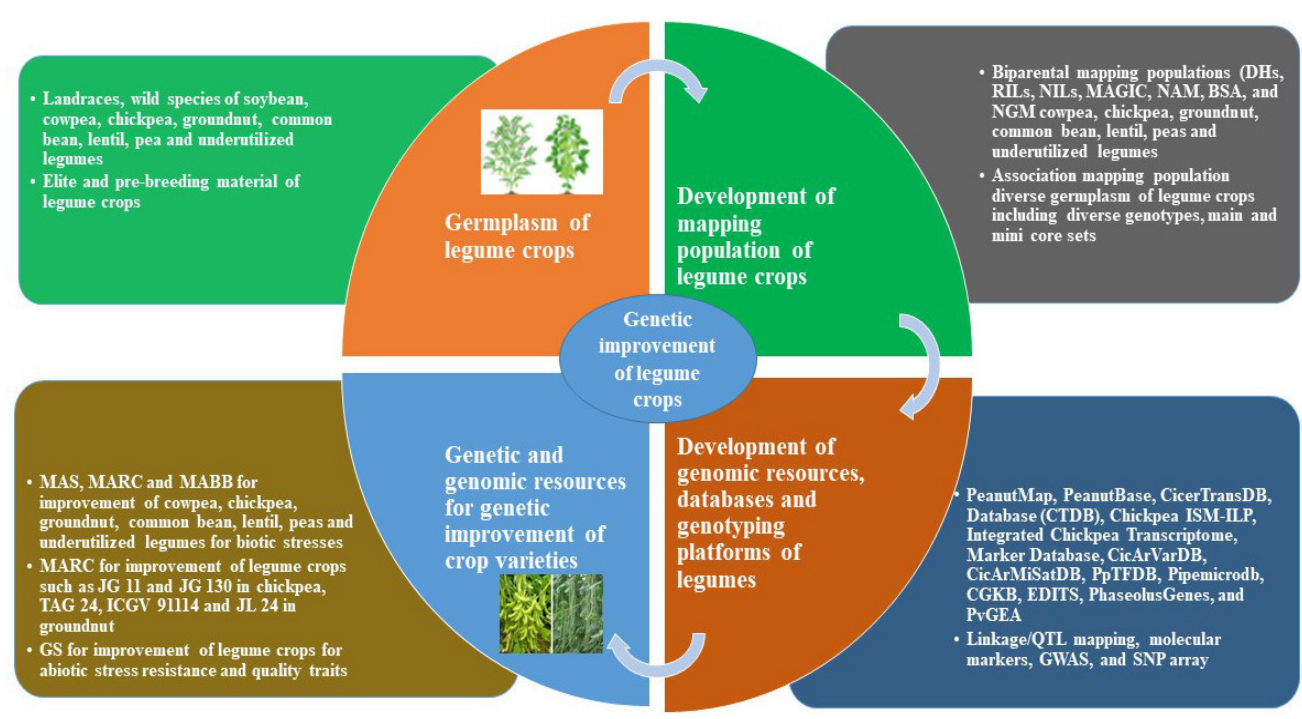
Figure 1. Steps involved in the development of genomic resources and deployment in legume crop improvement.